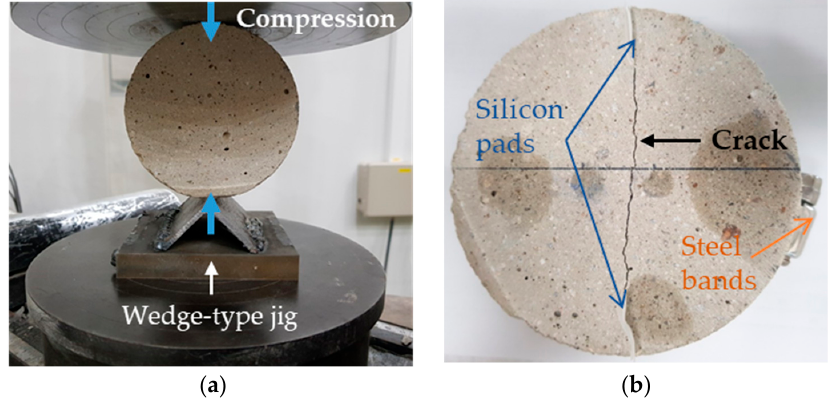
Figure 2. Fabrication of cracked specimens: ( a ) Splitting tension method; ( b ) A specimen with a realistic penetrating crack along the centerline through the thickness.